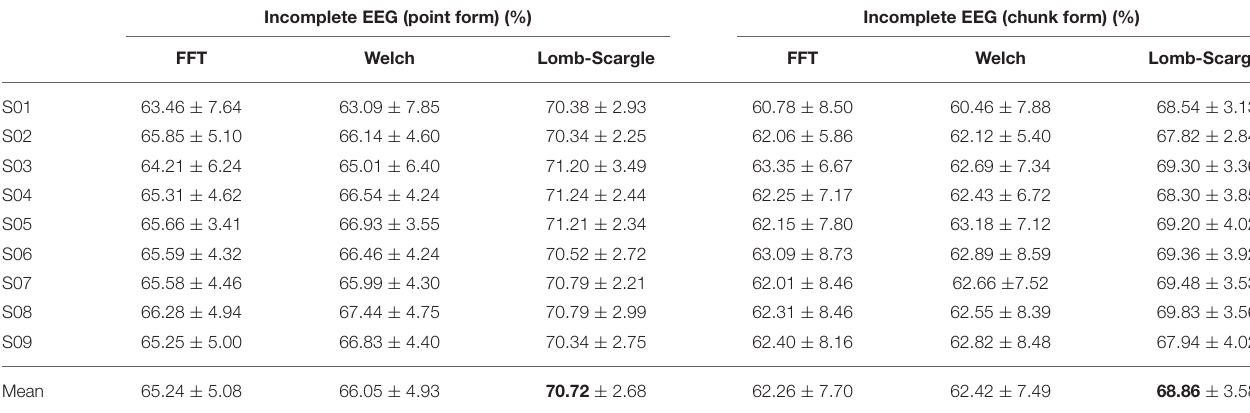
TABLE 1 | Statistical classification performance for the incomplete EEG with point and chunk